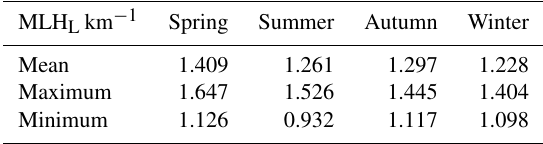
Table 1. Statistics of boundary layer height seasonal change.